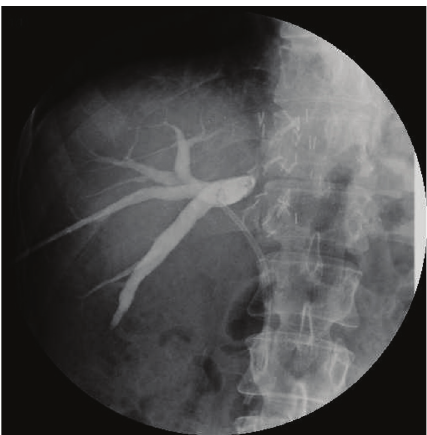
Figure 1: Percutaneous transhepatic cholangiography (PTC) show- ing the dilated segmental intrahepatic ducts excluded by the main biliary duct. A plastic stent is placed in the main duct.